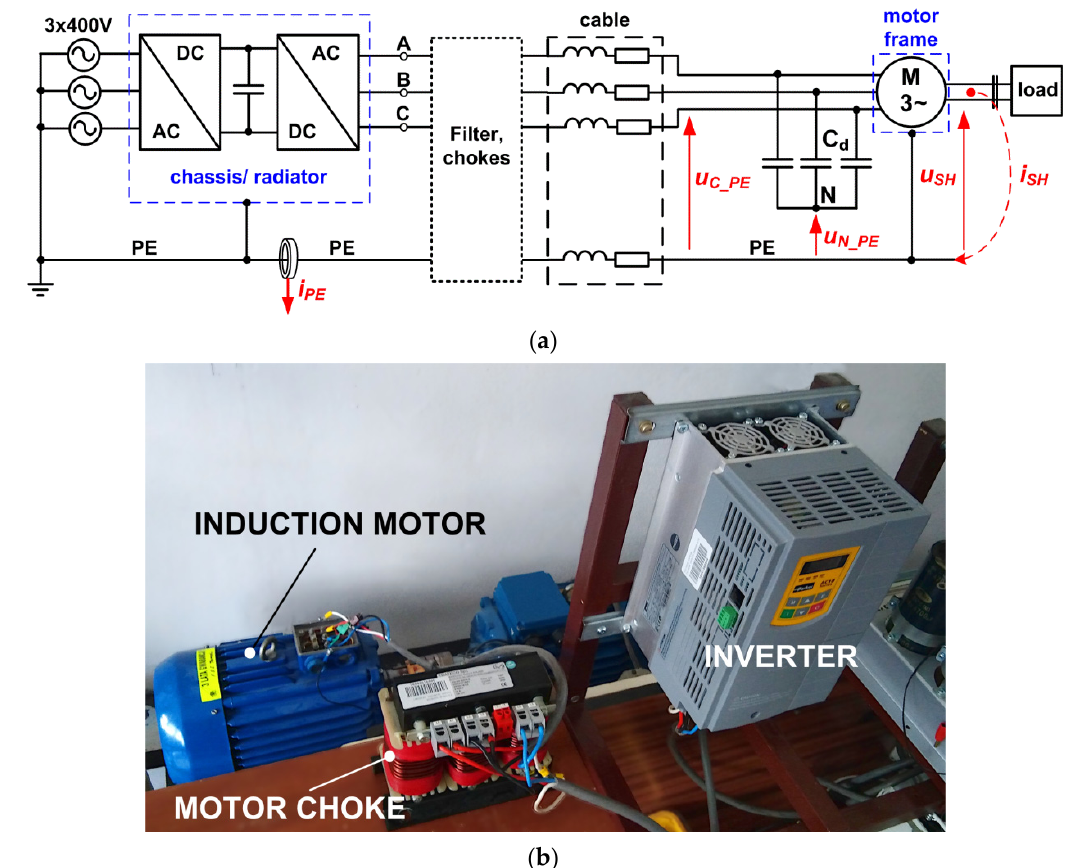
Figure 19. Laboratory setup for experimental tests: ( a ) scheme; ( b ) a photo of an experimental setup in a configuration with a motor choke.